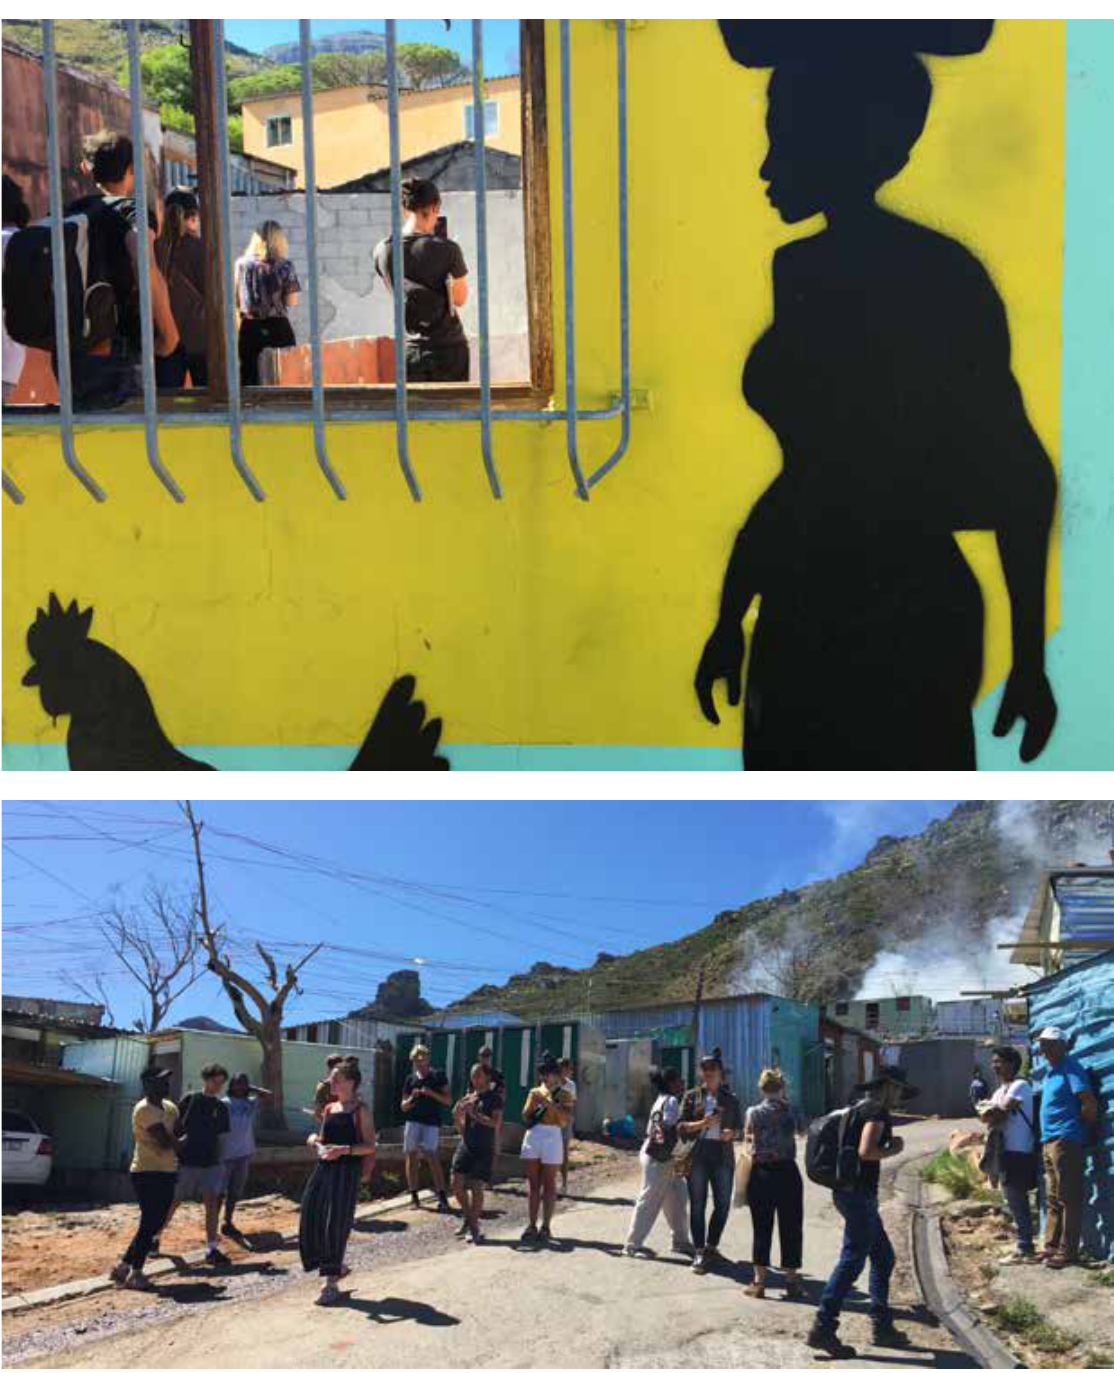
Figure 1 (top): Students surveying the burnt-out interior remains of a building in Imizamo Yethu which was severely damaged due to arson; the mural on the external façade was painted after the fire damage which results in a curious inversion of inside and outside.